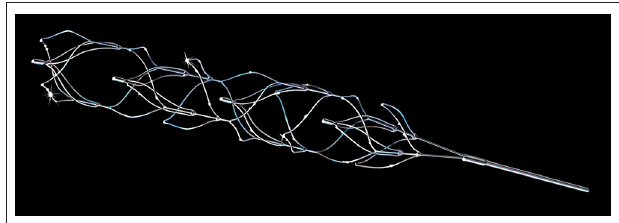
FIGURE 6 | Three-dimensional revascularization device from